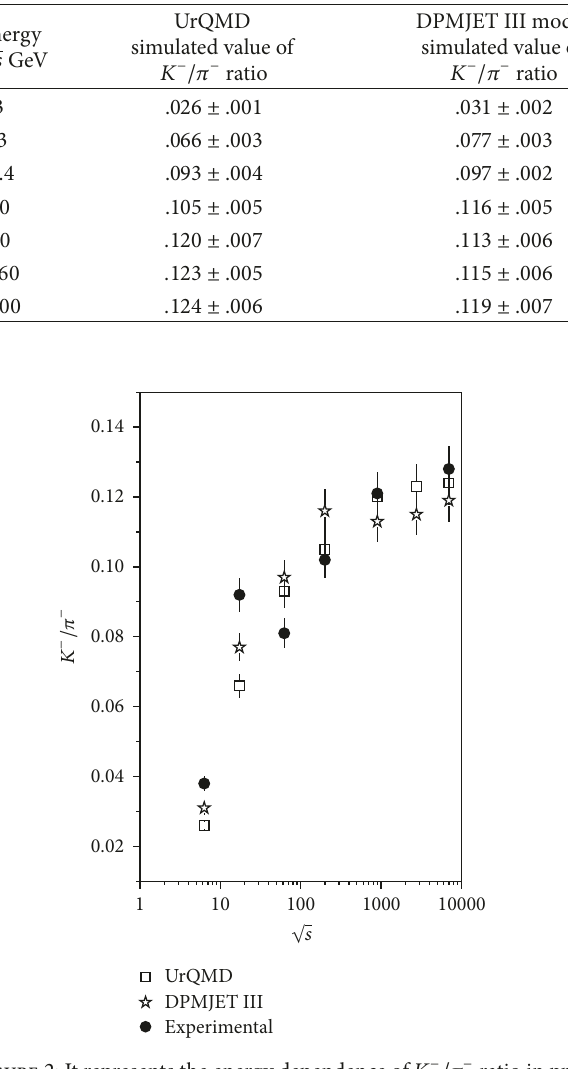
Figure 2: It represents the energy dependence of 𝐾 − /𝜋 − ratio in pp collisions at √𝑠 = 6.3 GeV to 7 TeV of the UrQMD, DPMJET III, and experimental